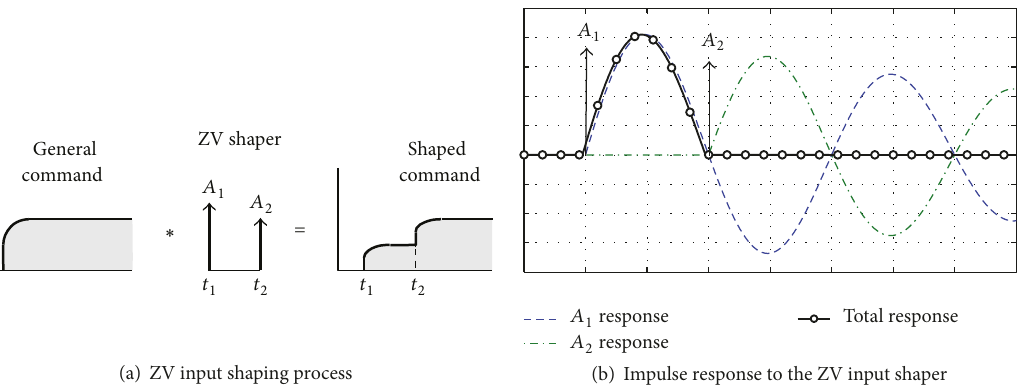
Figure 3: Zero-vibration (ZV) input shaping.